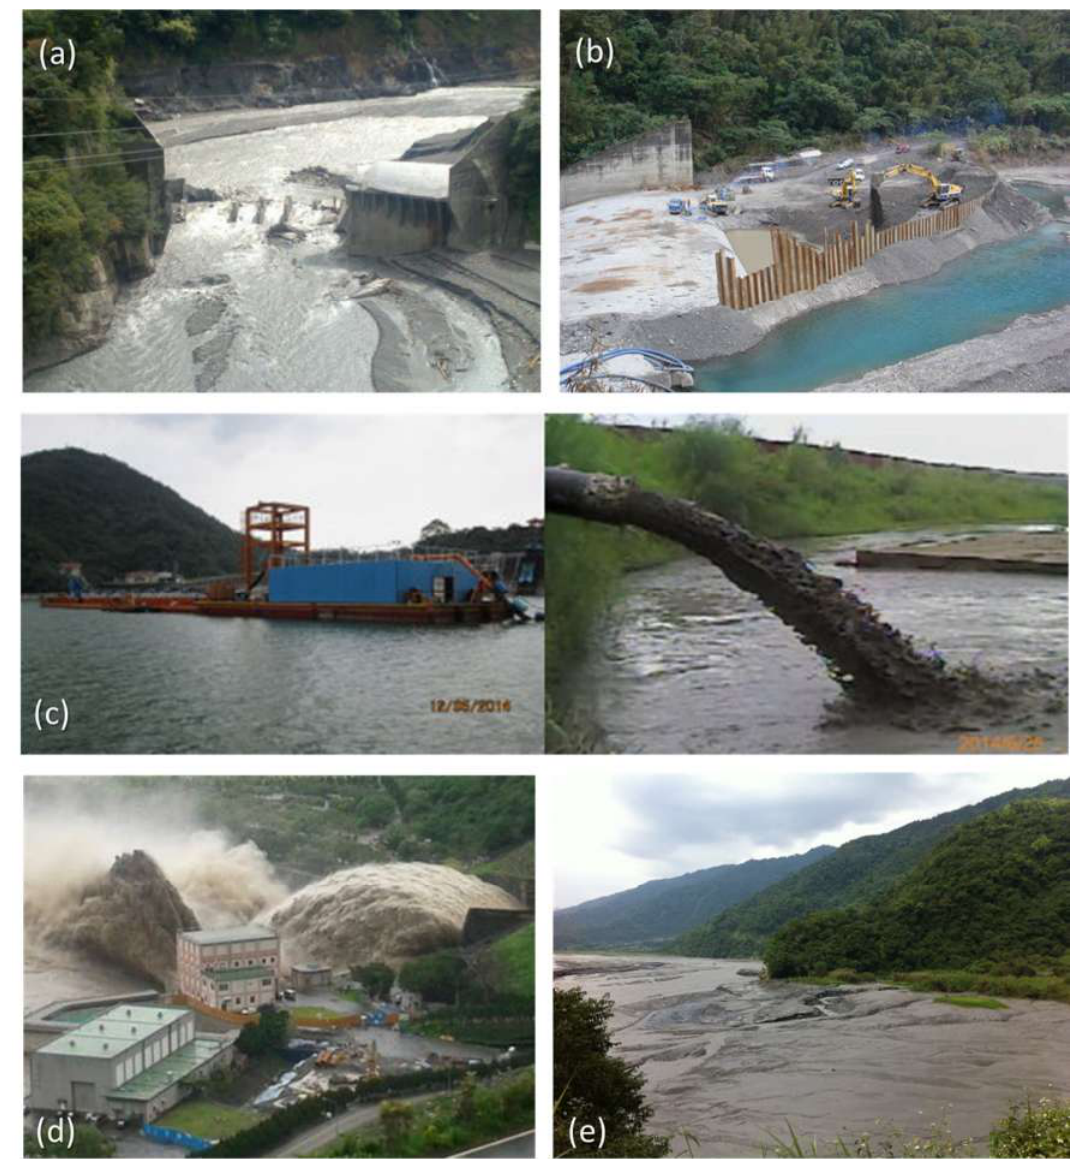
Figure 4. Images of sediment management strategies in Taiwan: ( a ) Barlin Dam, a failed sabo dam; ( b ) mechanical dredging from the lower most sabo dam, Yixing; ( c ) hydraulic dredging at Shihmen reservoir (WRA); ( d ) sluicing at Shihmen Reservoir during Typhoon Soulik in 2013 (WRA); ( e ) Drawdown flushing at Wujie Reservoir.